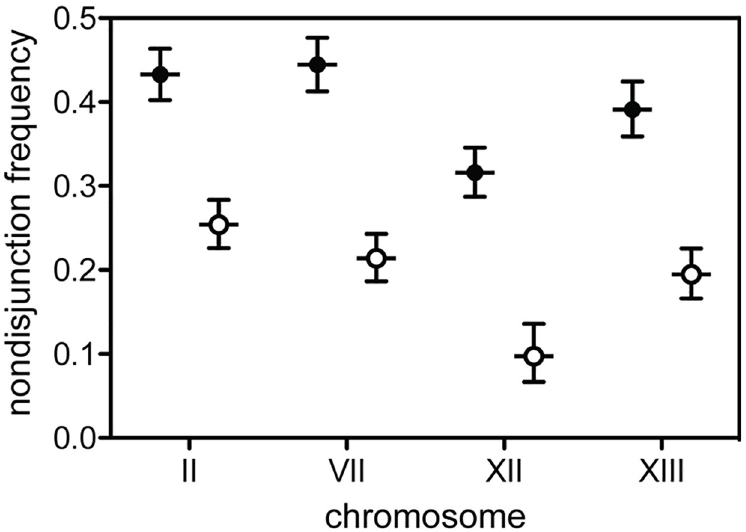
Fig 4. Impaired anti-recombination reduces meiosis I nondisjunction in interspecific hybrids. Eliminating expression of the RecQ helicase Sgs1 during meiosis (open symbols) lowered the rate of nondisjunction to approximately half of that seen in wild-type interspecific N17 × Y55 hybrids (closed symbols) for three of the tested chromosomes (II, VII, and XIII) and approximately one third for Chr XII. Underlying data can be found in S1 Data. Error bars represent binomial 95% confidence intervals calculated using JavaStat (http://statpages.info/confint.html). Chr, chromosome.